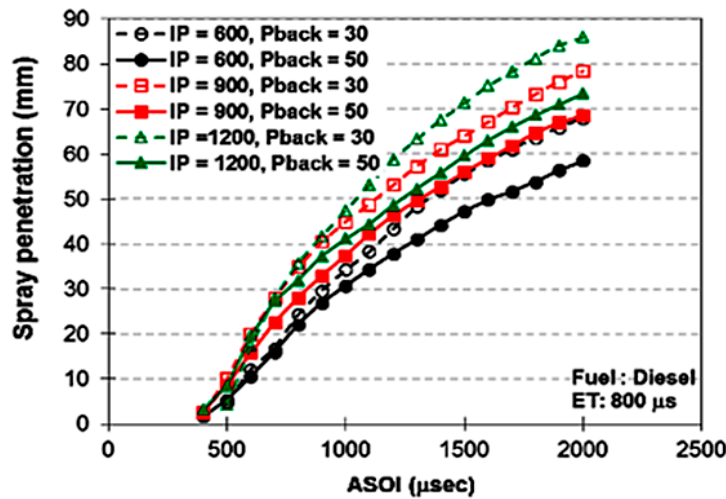
Figure 22. Spray penetration length at back pressure of 30 and 50 bar (Nozzle diameter: 0.30 mm, Injection pressure: 600, 900, and 1200 bar by common rail injection system) [34].